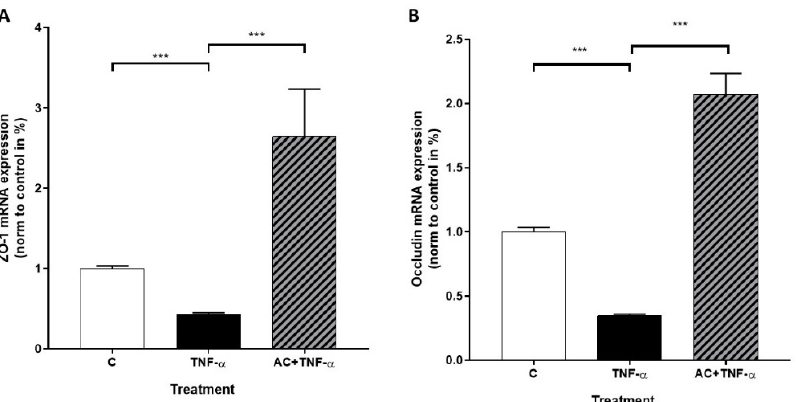
Figure 7. The effects of anthocyanin sour cherry extract on TNF- α induced ZO-1 and Occludin mRNA expression on Caco-2 cells. Cell cultures were treated with TNF- α (50 ng/mL) and 100 µM AC + TNF- α (50 ng/mL) for 24 h. The mRNA level of ZO-1 ( A ) and Occludin ( B ) were determined by RT-qPCR and target genes were normalized to GAPDH and control. Data are presented as mean ± SDs. n = 3. The significance of differences between sets of data was calculated by ANOVA. *** p < 0.001.